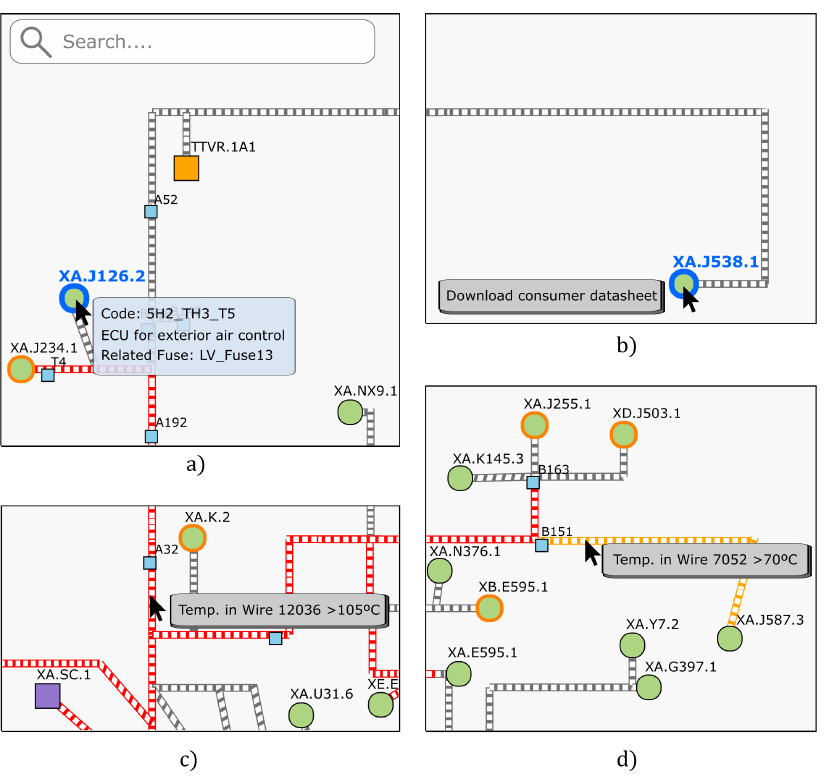
Figure 7. Examples of VA-based features. ( a ) Elements search box and tooltip on mouse-over. Contextual menus on right-click: ( b ) Download consumer datasheet, ( c ) Harness with wire having temperature > 105 ºC and ( d ) Harness with wire having temperature > 70